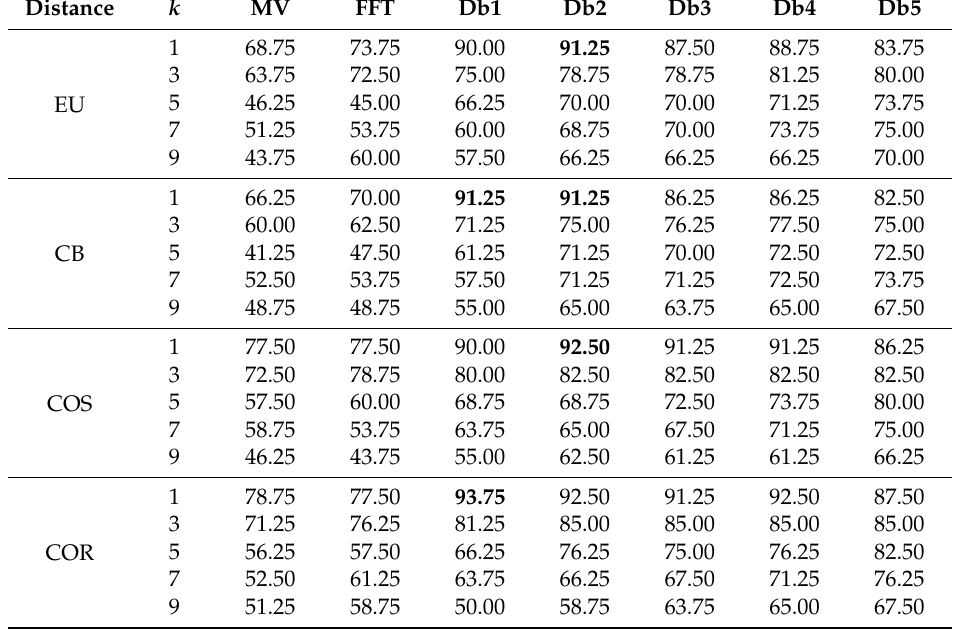
Table 5. Classification results of seven features based on different values of k and distance metrics for Dataset I